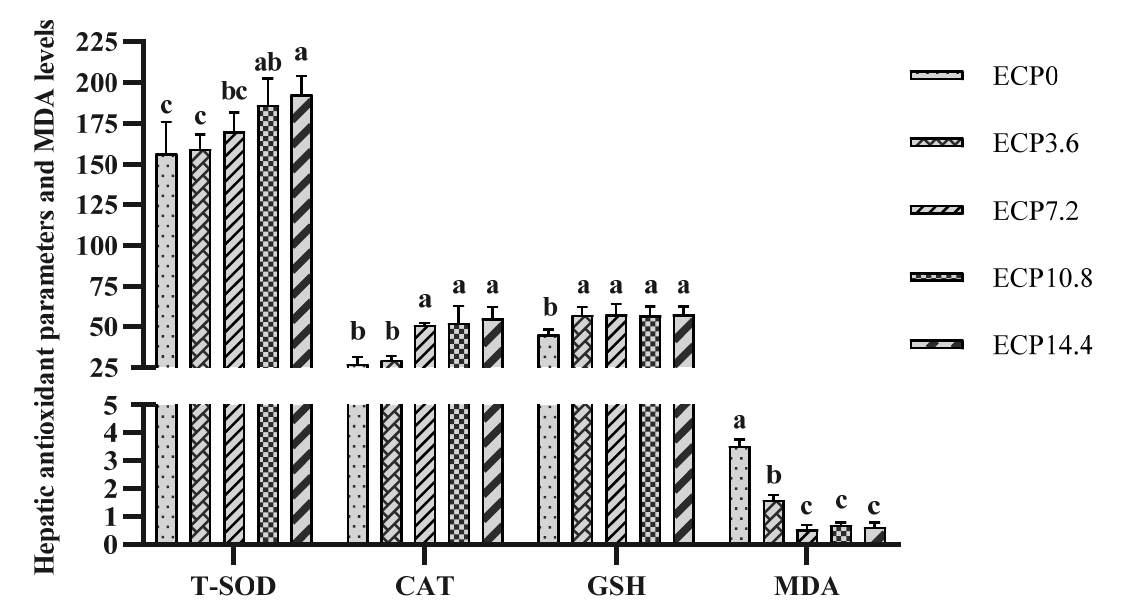
Figure 1. Hepatic antioxidant parameters and MDA levels. T-SOD, total superoxide dismutase; CAT, catalase; GSH, glutathione; MDA, malondialdehyde. Data are presented as mean ± SD. Bars with different superscripts indicate significant differences ( p < 0.05), while that with the same letter or no letter superscripts indicate no significant differences ( p > 0.05).